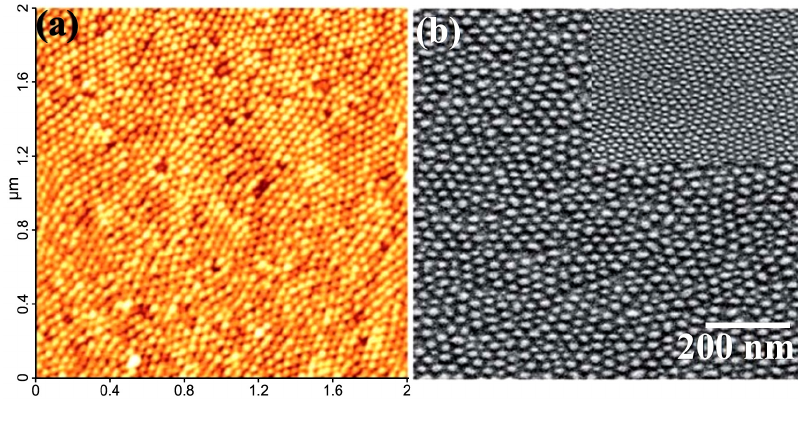
Figure 27. ( a ) AFM; and ( b ) SEM images for hexagonally ordered iron oxide nanodots after UV/ozone treatment. The inset of ( b ) shows the iron oxide nanodots after annealing at 800 °C for 1 h. Reprinted with permission from [49]. Copyright 2012 Royal Society of